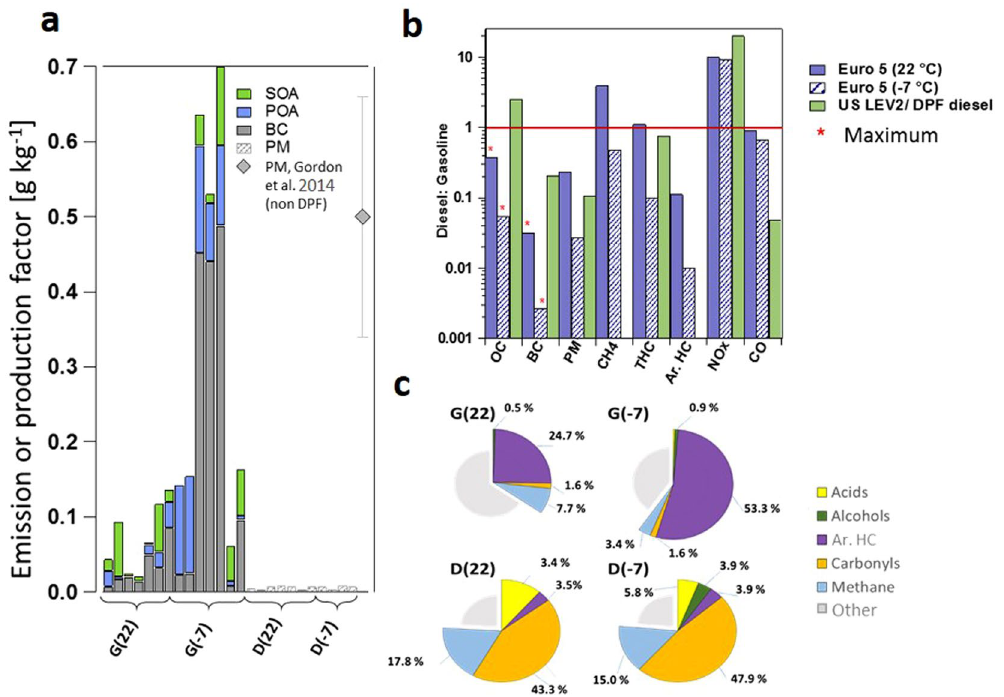
Figure 2. Carbonaceous emissions/secondary organic aerosol formation from modern diesel and gasoline passenger cars. ( a ) Aerosol emission factors (g kg − 1 fuel) measured in this study. SOA is at OH exposure = 10 7 molec. cm − 3 h. Diesel vehicles did not produce measurable OA so gravimetric PM is given. For comparison the average and standard deviation of PM emission factors from non-DPF medium duty diesels from Gordon et al . 2013 ref. 3, is shown. ( b ) Average ratio of diesel/gasoline emission factors for OA, BC, PM, methane (CH 4 ), total hydrocarbon (THC), aromatic hydrocarbons (Ar. HC), nitrogen oxides (NO X ) and carbon monoxide (CO) at 22 °C and − 7 °C. Euro 5 values are obtained using the NEDC, while US LEV2 and DPF-equipped vehicles use the US unified driving cycle, UC 3, 21 . While a true ratio cannot be calculated for OC and BC, a maximum can be, based on detection limits, highlighted by the red asterisks ( * ). In contrast to CO and especially NO X , PM and hydrocarbon emissions from gasoline cars are higher than from diesel cars. ( c ) Averaged THC-normalised exhaust composition (temperature in parentheses) in the smog chamber with uncharacterised emissions in grey. The single largest fraction of gasoline THC consists of methyl benzenes present in the fuel, while the rest likely consists of surviving linear/branched, saturated/unsaturated hydrocarbons. Meanwhile, diesel emissions mainly comprise pyrolysis products, including small carbonyls (formaldehyde, acetaldehyde) and carboxylic acids (formic, acetic), which are not efficient SOA precursors. Supporting material related to Fig. 2 available in SI Tables S3–7,